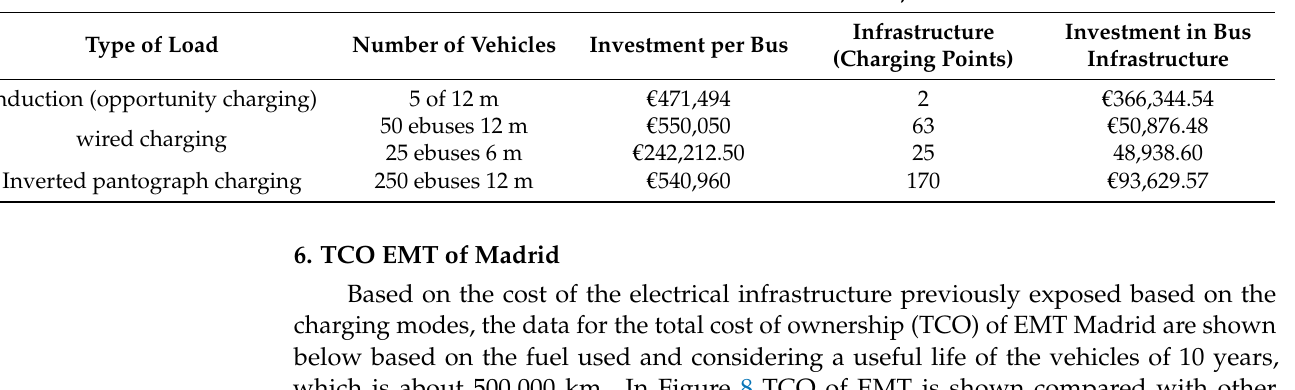
Table 10. Summary of actual charge systems in Carabanchel OC.